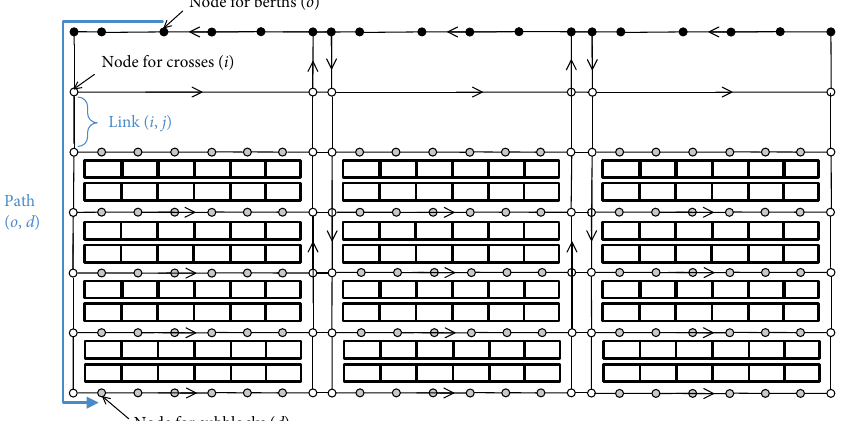
Figure 2. The yard network denoted by nodes and links